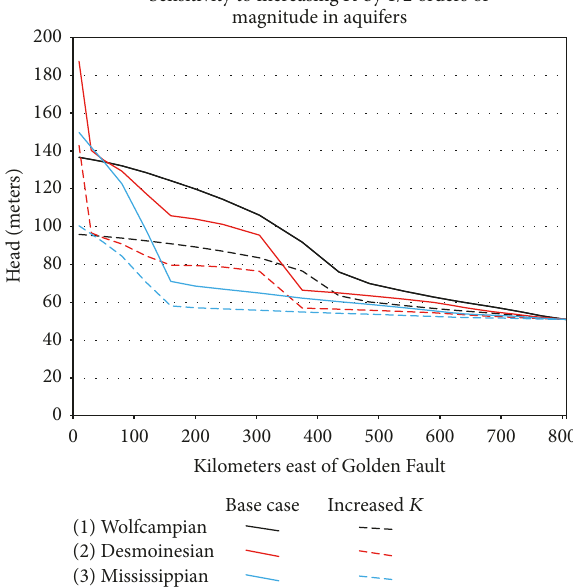
Figure 21: Sensitivity to doubling the flux in the west.